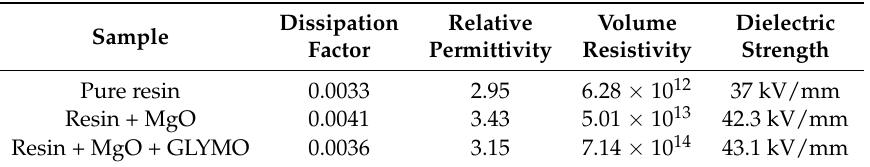
Table 3. Comparison of selected parameters after surface